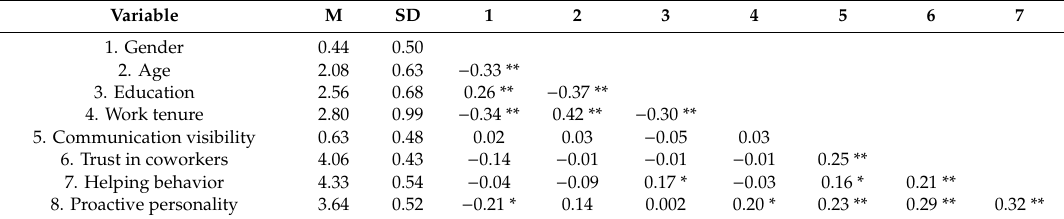
Table 2. Means, standard deviations, and correlations among